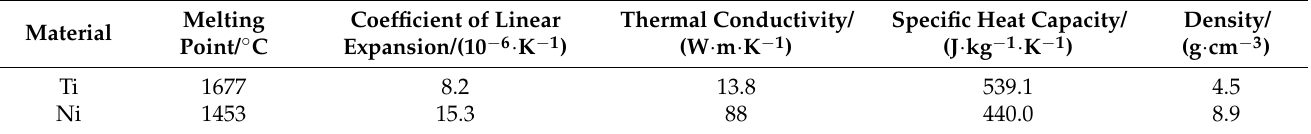
Table 4. Main physical properties of Ti and Ni